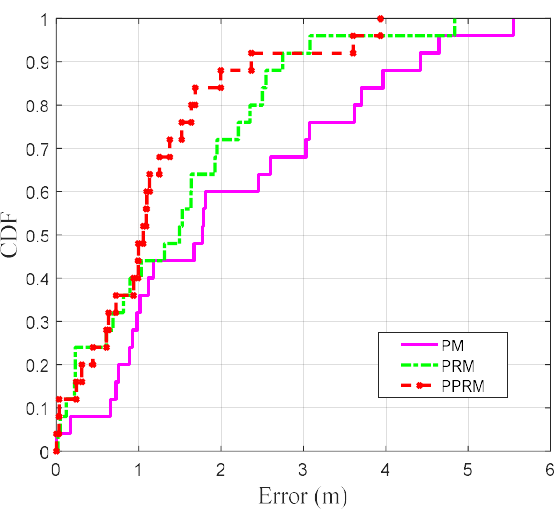
Figure 6. Cumulative distribution functions (CDFs) of offline distance estimation errors under three models.